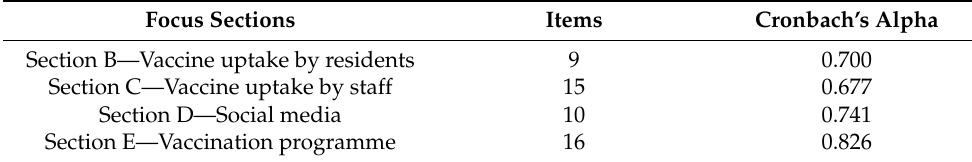
Table 1. Estimated Cronbach’s alpha tests for the administered